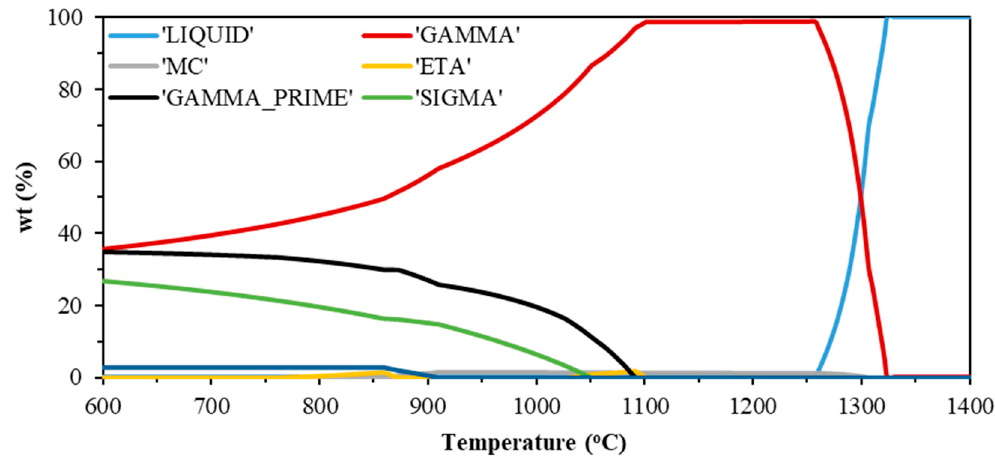
Figure 3. Phase equilibrium diagram of IN-939 obtained from JMatPro ® simulation software.